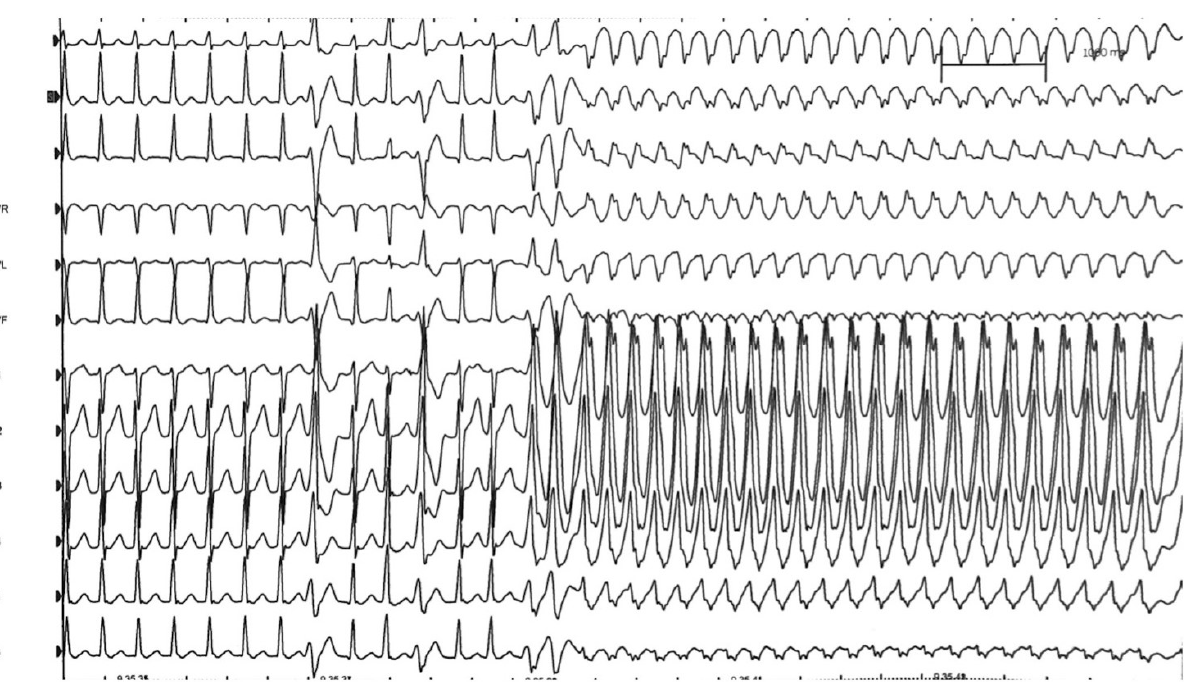
Figure 5. Electrophysiological Study : atrial fibrillation with a very high ventricular rate response along a left accessory pathway degenerating into ventricular fibrillation.